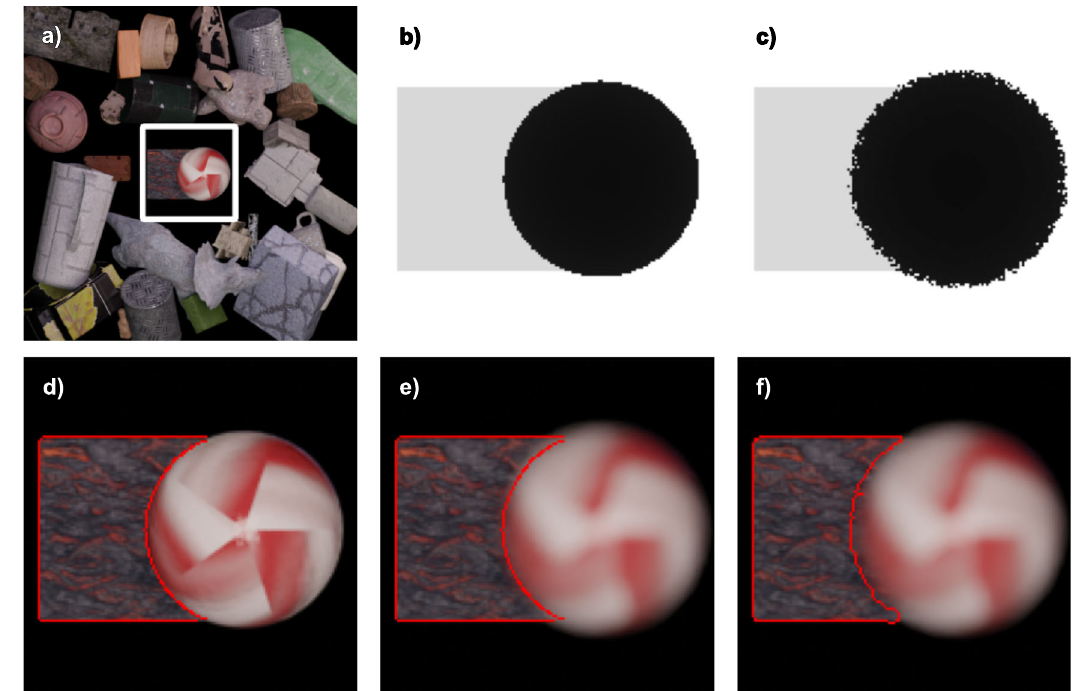
Fig. 9 | All-in-focus depth map and defocus-blur-considered depth map over- laid on a color image. a All-in-focus rendered image. White box indicates an enlarged area for other sub fi gures. b Enlarged all-in-focus depth map. c Defocus- blur-considered depth map for the rear plane of focus. While acquiring the depth valuesinthe area of the defocus blur,the depth values of the front object and that of the rear object were randomly sampled by the renderer. To ignore the depth valuesoftherearobjectneartheboundary,thedepthmapswereacquiredmultiple